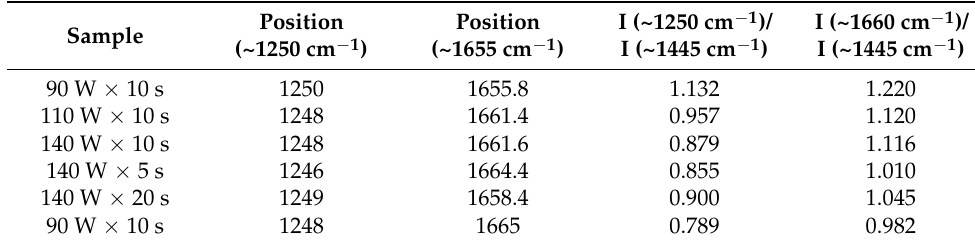
Table 2. Raman Spectrum Result.